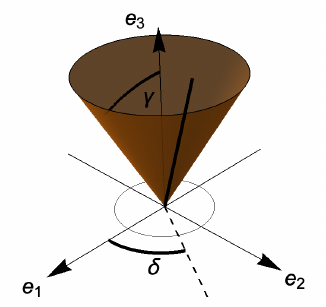
Figure 2. Reference frame fixed to the planet. The angle γ is the inclination of the rotation axis, the angle δ mismatches aphelion/perihelion from